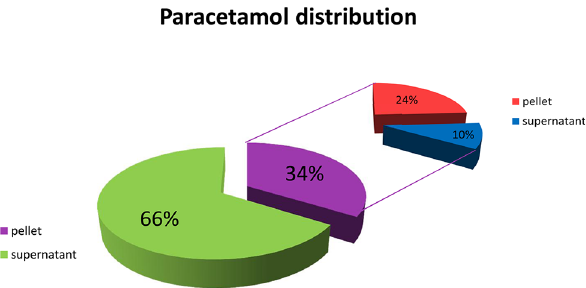
Fig 3. Encapsulation of paracetamol by the meal. The meal containing paracetamol was mixed with a hydrochloric acid solution (pH 2) in a test tube to mimic the conditions in the stomach. After centrifugation two thirds of the paracetamol was retrieved in the supernatant. Extraction of the pellet with buffer (150 mM sodium phosphate buffer, pH 7.4) released one tenth of the paracetamol. doi:10.1371/journal.pone.0136618.g003 Fig 2. This indicates that slow release in the intestine of the paracetamol that is encapsulated by